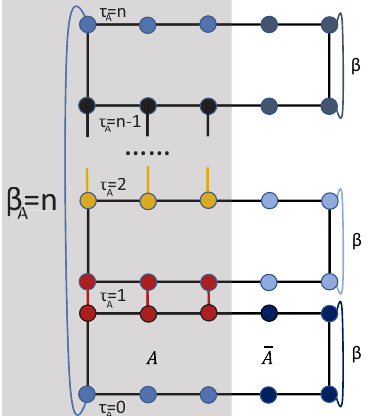
Fig.1|Ageometricalpresentationofthepartitionfunction Z ð n Þ A . Theentangling region A bewteen replicasisglued together in the replica imaginary time direction andtheenvironmentregion A foreachreplicaisindependentintheimaginarytime direction. Therefore, the imaginary time length for H A is β A = n and that for total system H is β =1/ T